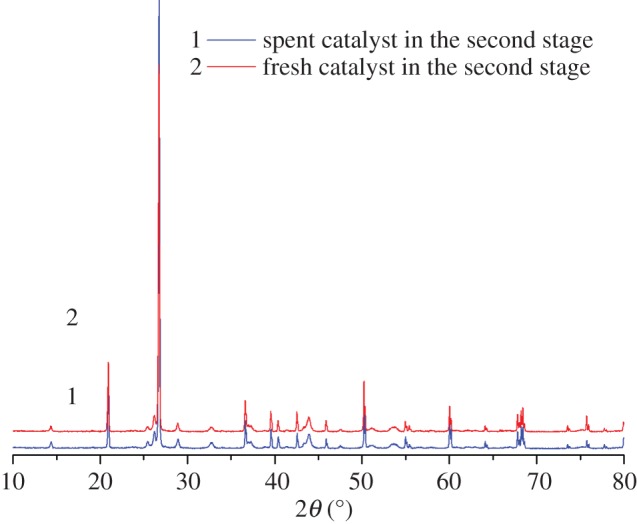
XRD patterns of the NiOx–MoOy/SiO2 catalysts in the second stage.